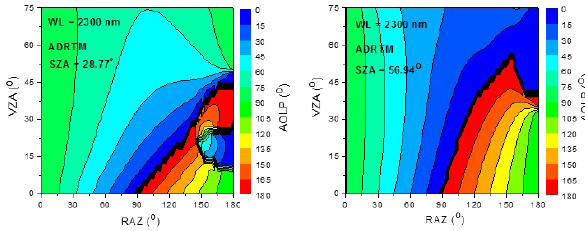
Figure 25. The modeled AOLP of desert-reflected solar light at the wavelength of 2300nm. The SZA is 28.77 and 56.94 ◦ , respectively, in the